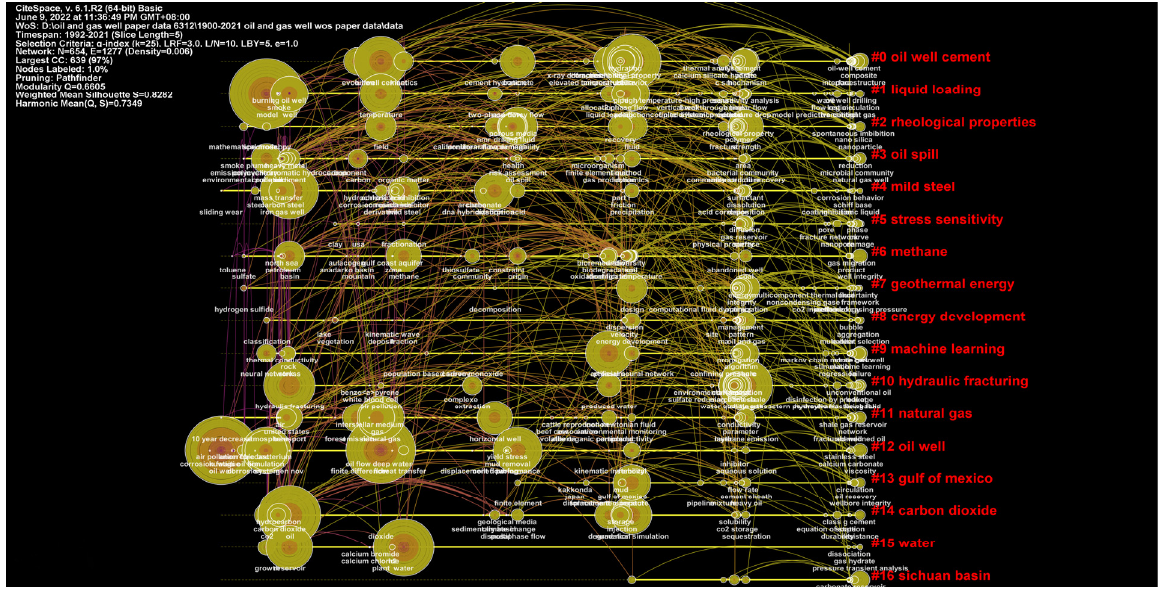
Figure 14. A timeline visualization of the 17 hotspots in the field of oil and gas wells, 1992–2021.